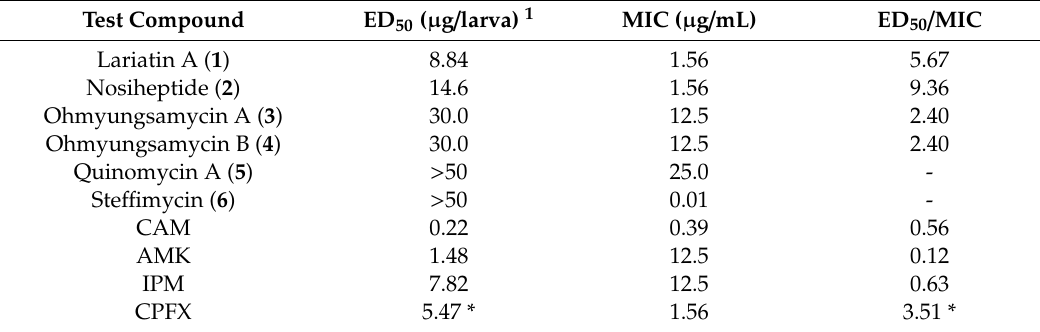
Table 2. MIC and ED 50 values of anti-mycobacterial agents against My.